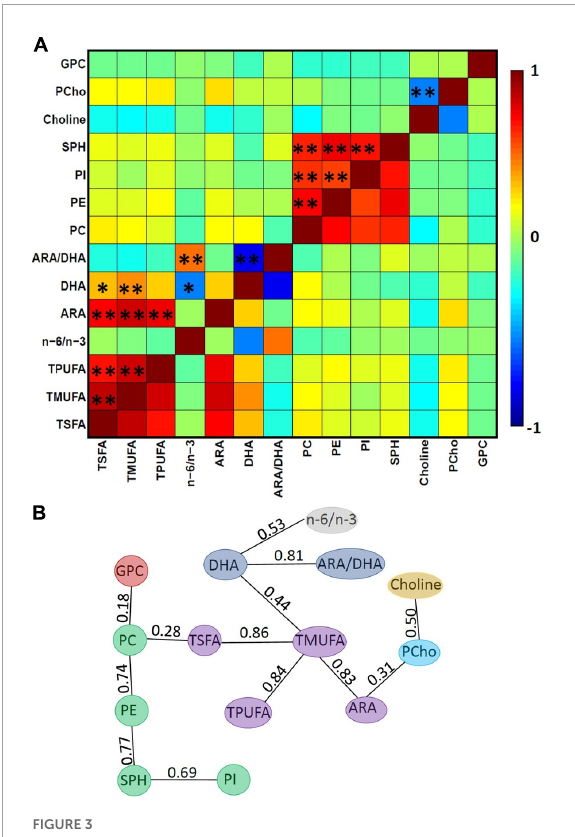
FIGURE3 Relations between nutrients. (A) Pearson’s correlation between each pair of the 14 nutrients, where single asterisks ( ∗ ) and double asterisks ( ∗∗ ) represent a raw p -value of < 0.05 and adjusted p < 0.05, respectively, using the standard Pearson correlation test and the FDR correction. (B) The minimum spanning tree, where colors represent different clusters and numbers represent the correlation coefficients between a given pair of nutrients. Note the optimal clustering result is stable for 0.53 < T c ≤ 0.69. In addition, the minimum spanning tree shows that the strongest correlation between the clusters (PC, PI, PE, and SPH) and (TSFA, TMUPA, TPUFA, and ARA) is between the pair of TSFA and PC (0.28). It implies that only when T c ≤ 0 . 28, these two clusters will merge together, while PCho and choline are closer in the sense that these two will merge when T c ≤ 0 . 50